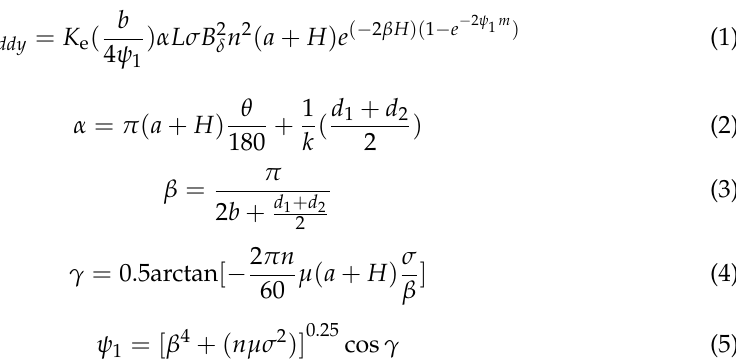
Figure 4. Result of eddy current loss analysis on the rotor.